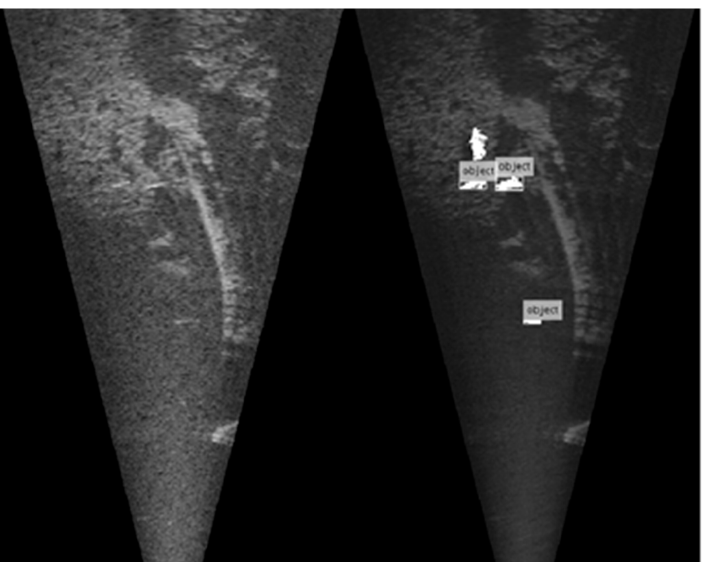
Figure 11. Layout for the manual target detection (left) and comparison to automatic criteria-based (50 px < object area < 350 px) target detection (right) result. Total detections, total correct detections and total misdetections were counted.